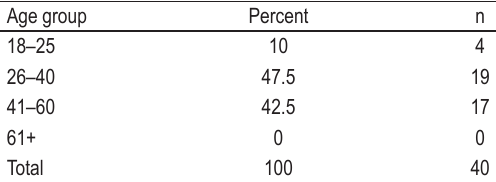
TABLE 2. Age groups of 40 individuals with hearing and